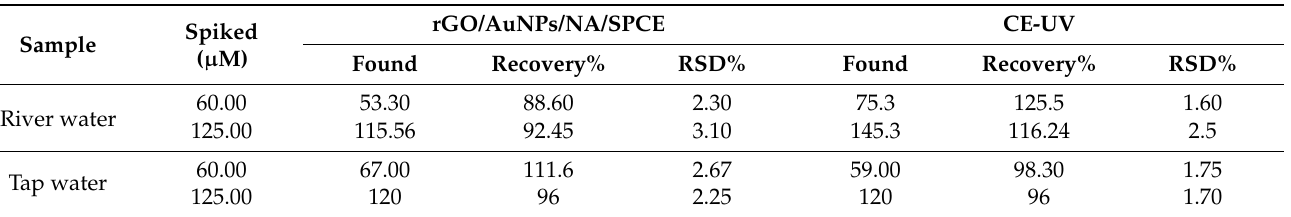
Table 2. Carbaryl concentration in spiked samples using the developed rGO/AuNPs/NA/SPCE and traditional CE.